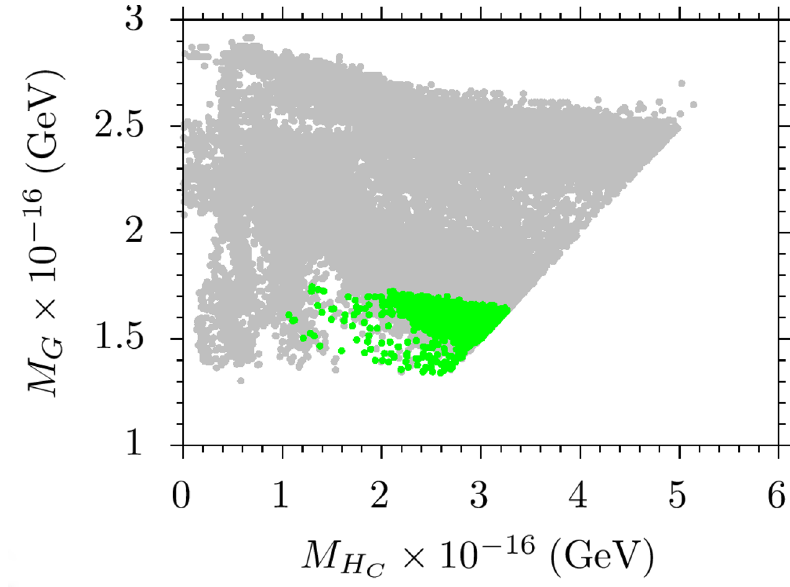
Figure 2 . Allowed parameter space in the M G − M H plane in SUSY SU(5) without threshold C effects. Here we use the definition M G = ( M 2 M Σ ) 1 / 3 . All points are compatible with the radiative X electroweak symmetry breaking and the LSP being a neutralino. Green points are allowed by the Higgs boson mass, LHC bounds on SUSY masses and B -physics